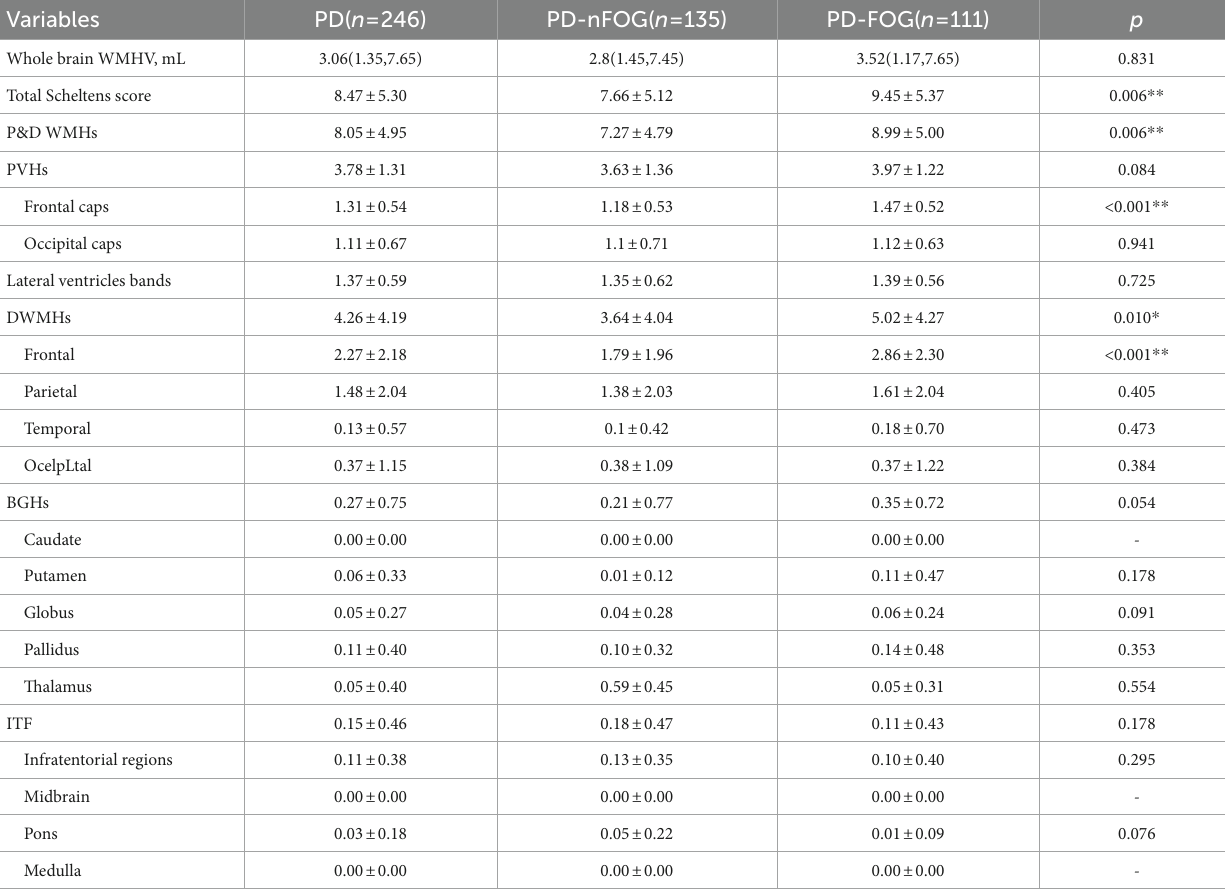
TABLE 3 Comparison of whole brain white matter hyperintensity volume and WMHs scores of the two participants groups.